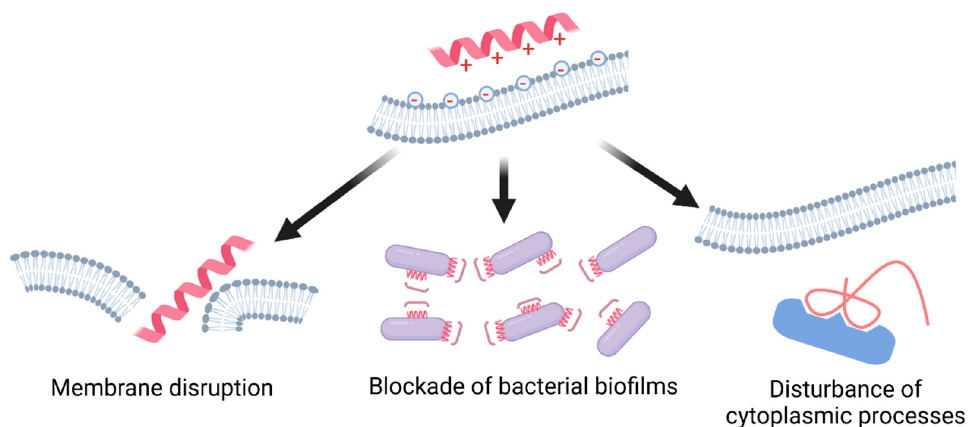
Figure 1. Multiple mechanisms of action of antimicrobial peptides. Figure created with BioRender.com (accessed on 27 June 2022)